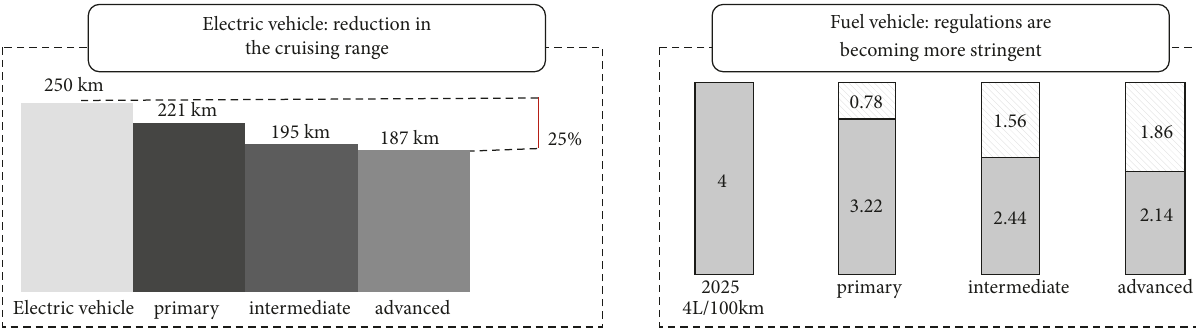
The automatic function hardware operation energy con- sumption is calculated through Eq.